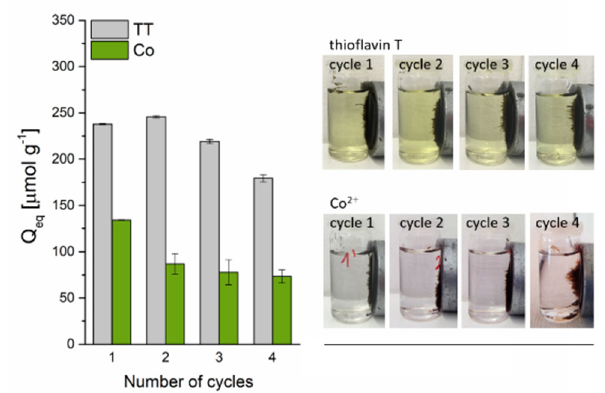
Figure 11. The reusability of magnetically responsive biosorbent (2.5 g L − 1 ) for Co 2 + (C 0 = 1 mmol L − 1 CoCl 2 ) and TT (C 0 = 0.63 mmol L − 1 ) adsorption. Regeneration using 0.1 M HCl (Co-loaded) and 0.1 M CH 3 COOH (TT-loaded) at L/S = 0.8 L g − 1 .